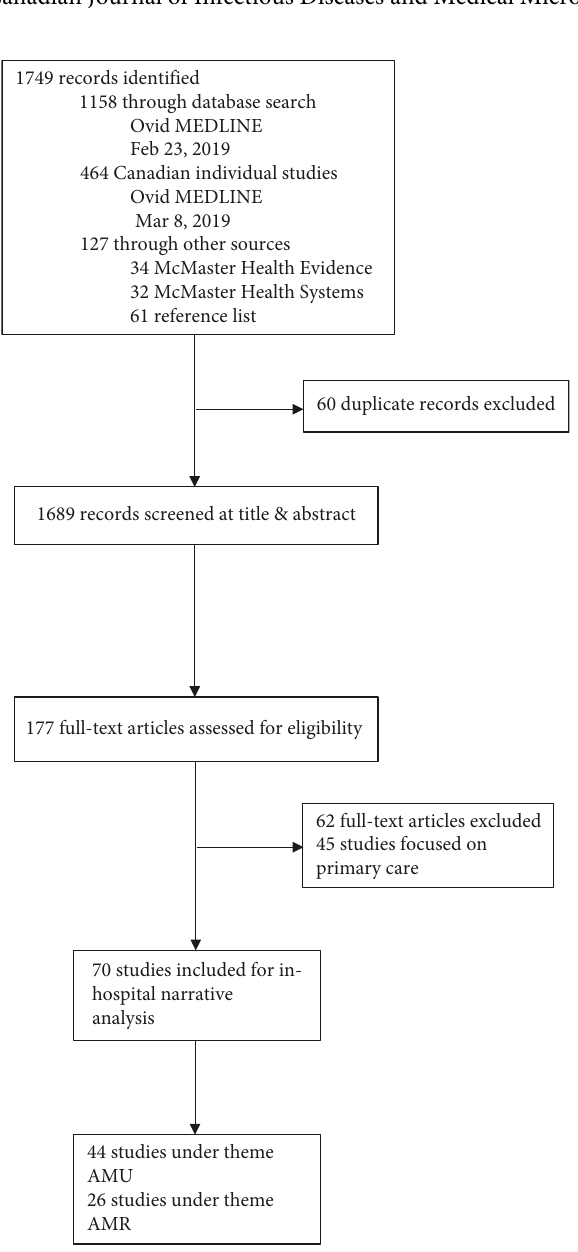
Figure 1: PRISMA flow diagram of study selection. AMU: anti- microbial use; AMR: antimicrobial